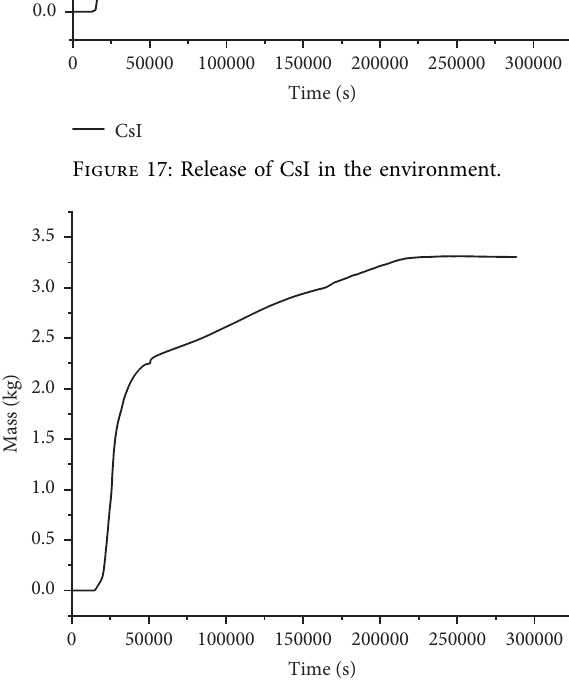
Figure 18: Release of Ba in the